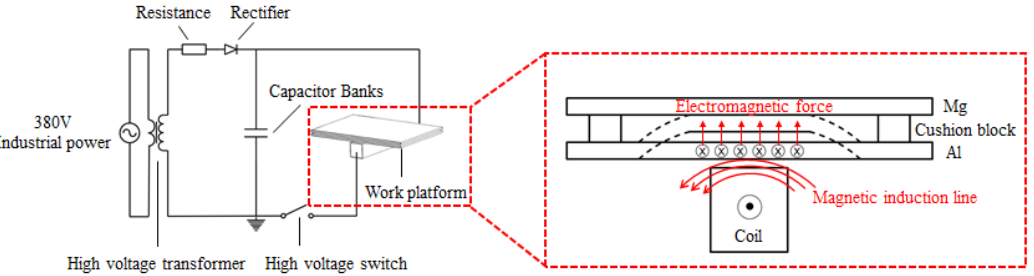
Figure 2. The principal configuration of MPW process.